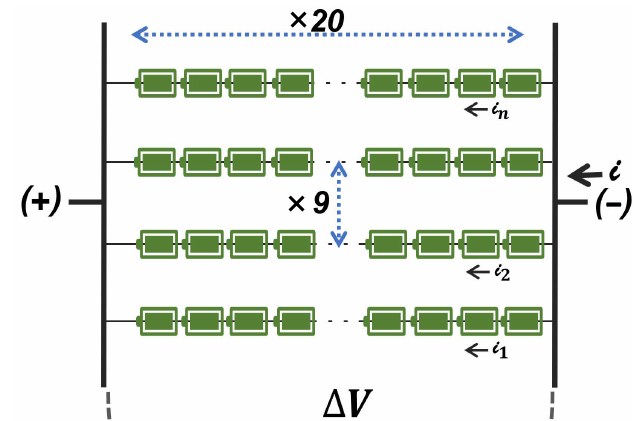
Figure 4. Battery pack modeling: 9 modules are connected in parallel and each module has 20 cells connected in series, each single one modeled as an independent ECM: ’i’ is the battery pack current, and ∆ V is the voltage of the battery pack.